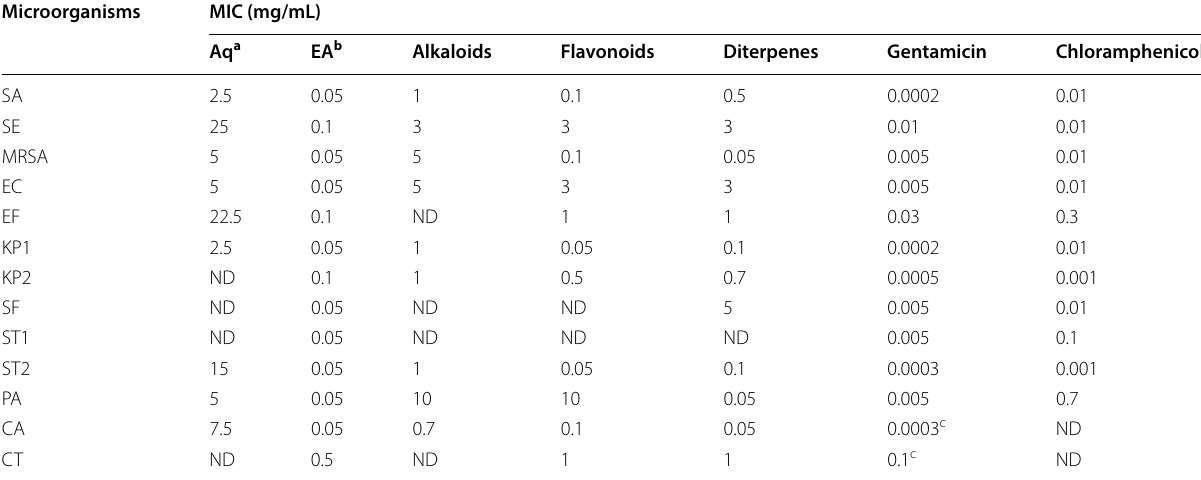
Table 4 Minimum inhibitory concentration (MIC) of Berberis aristata extracts, its partially purified phytoconstituents (PPPs) and standard